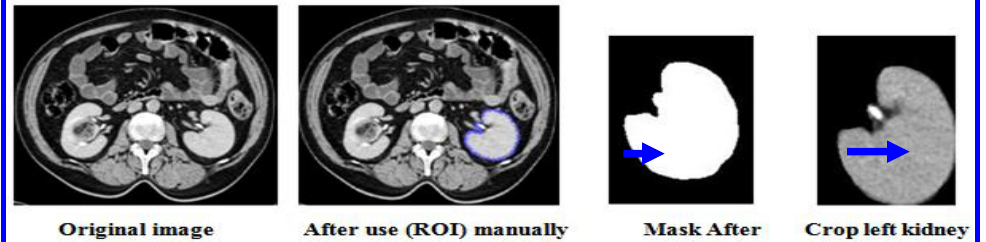
Fig. 2: The mask creation performed to crop the left kidney region.